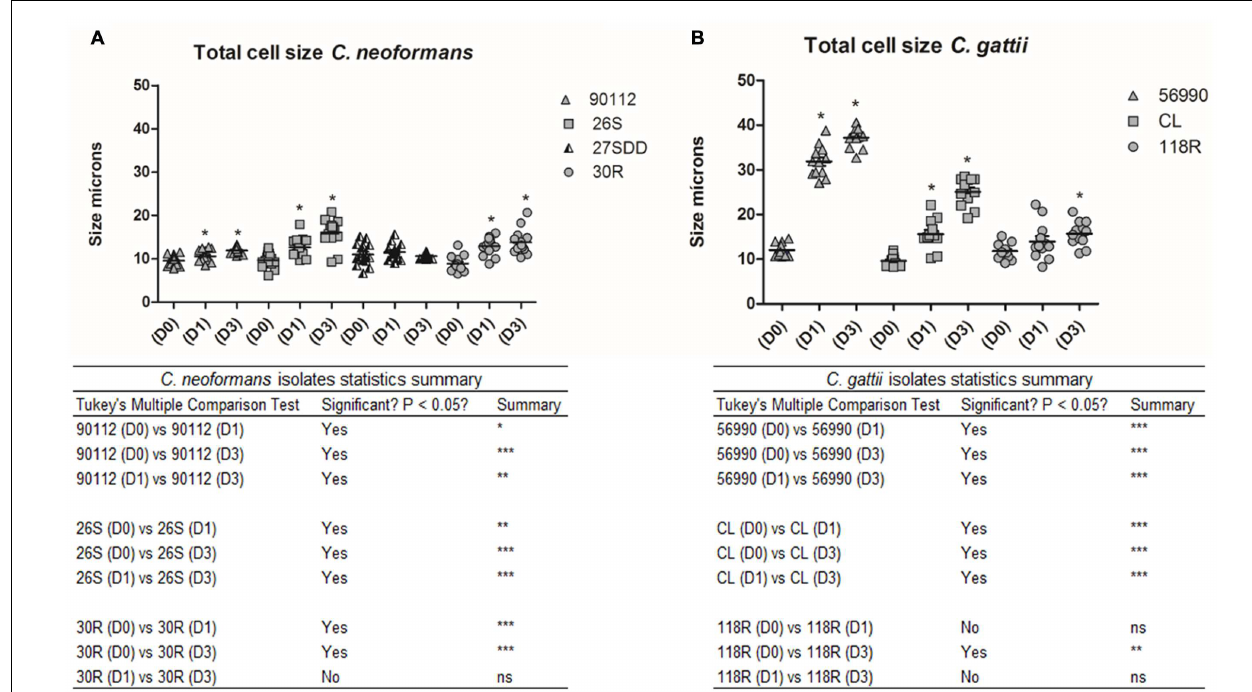
FIGURE 5 | Total cell size in microns for C. neoformans and C. gattii isolates during infection in G. mellonella . The cells were recovered from G. mellonella at different times (D1 and D3) and controls were grown in Sabouraud (D0). (A) ATCC 90112 and sequential clinical isolates 26S, 27SDD, and 30R of C. neoformans ; (B) ATCC 56990 and isolates CL and 118R of C. gattii . ∗ p < 0.05; ∗∗ p < 0.01; ∗∗∗ p <